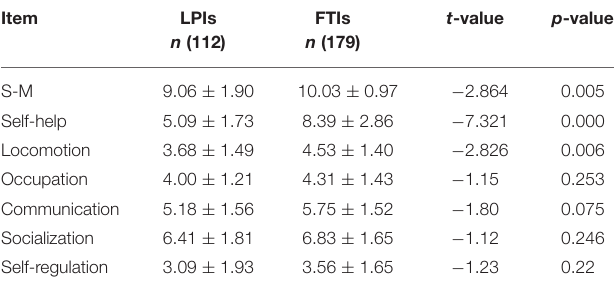
TABLE 3 | Comparison of scores in S-M between LPIs and FTIs ( x ± s).